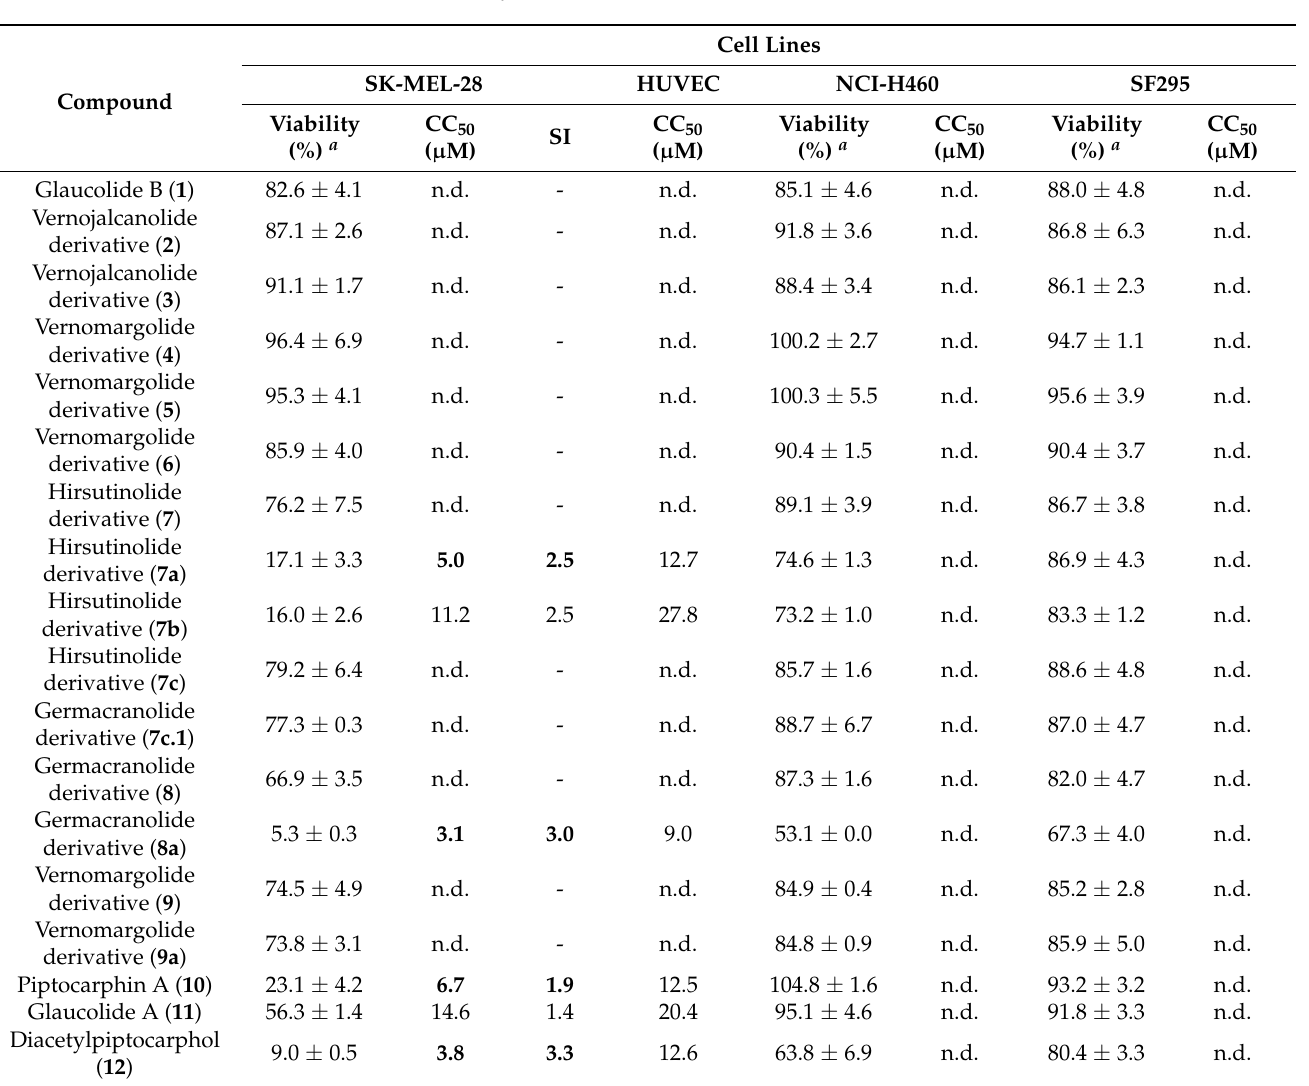
Figure 11. The proposed mechanism for the formation of SL semisynthetic derivative 7c.1 (red arrows illustrate the arrow-pushing mechanism). Table 1. Viability, CC 50 , and selectivity index (SI) values for the cytotoxic activity of the sesquiterpene lactones and semisynthetic